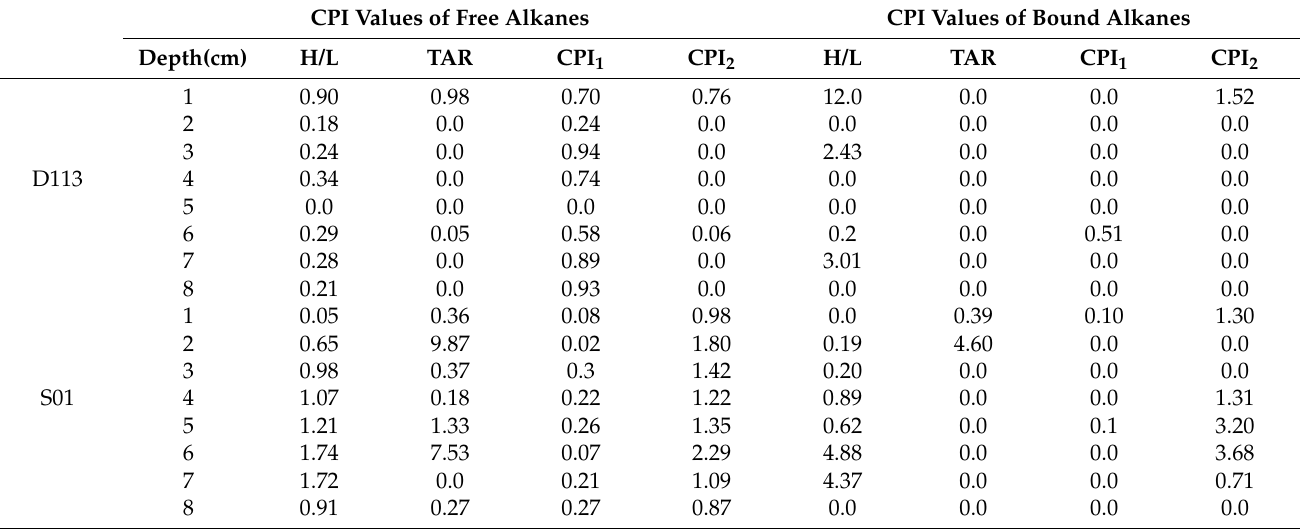
Table 3. CPI values of Alkanes from sediments of the Yap